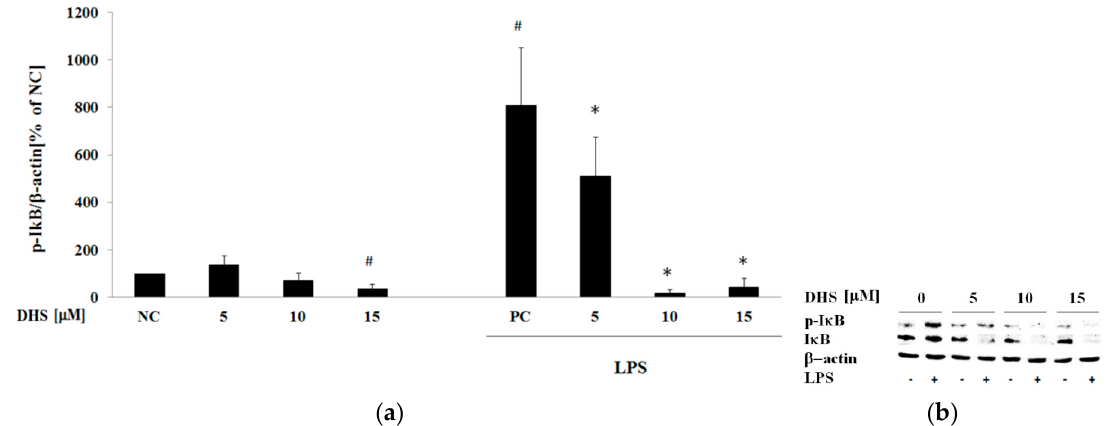
Figure 5. Western blot analysis of NF ‐κ B activation. The evaluation of transcription factor NF ‐κ B